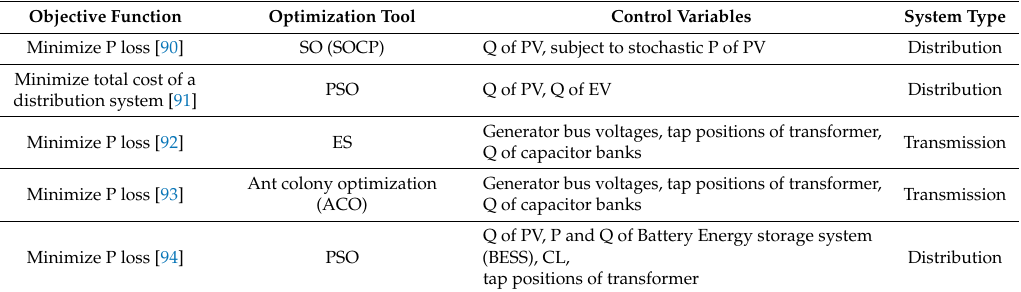
Table 7. A summary of literature works surveyed related to optimization.